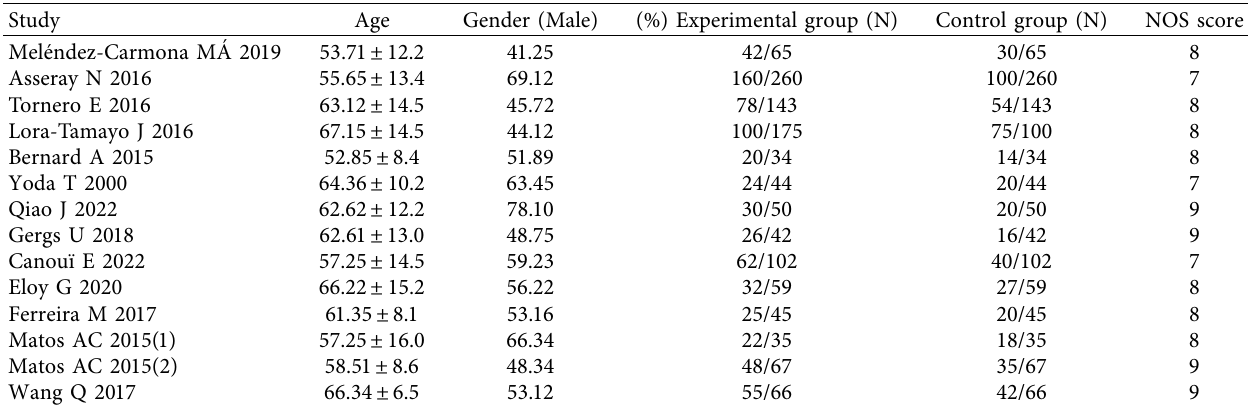
Figure 3: a-d: Funnel plot of literature publication bias. Table 1: Basic clinical features of 14 literature were included in our